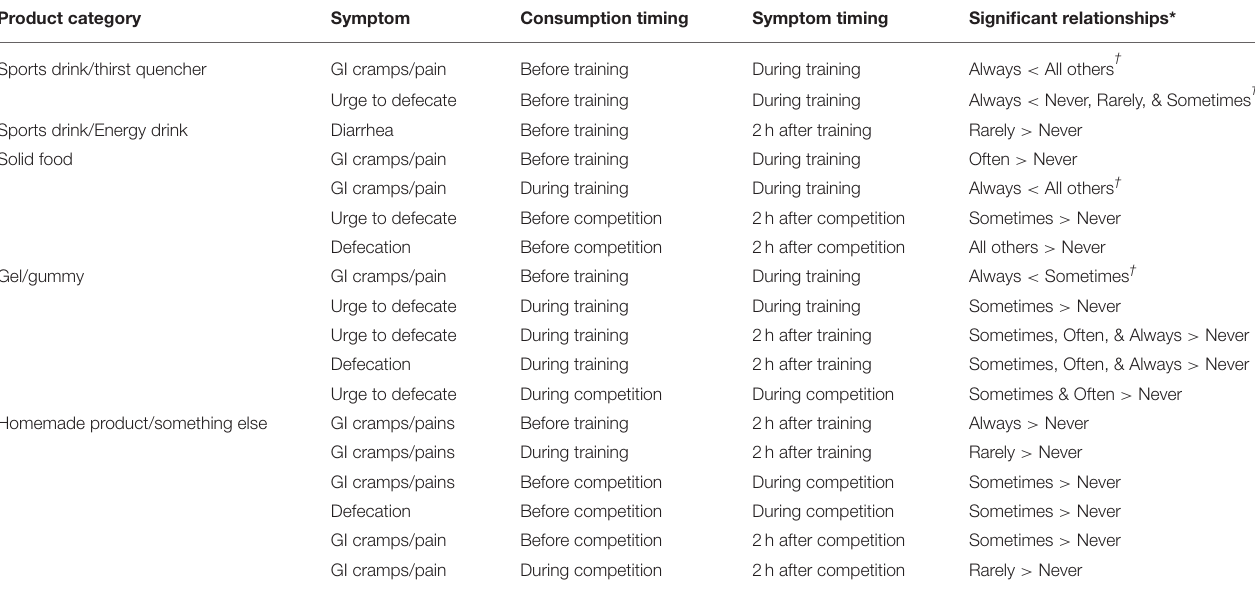
TABLE 2 | Associations of nutrition product category consumption frequency with more problematic gastrointestinal (GI) symptom frequency surrounding training and competition. Product